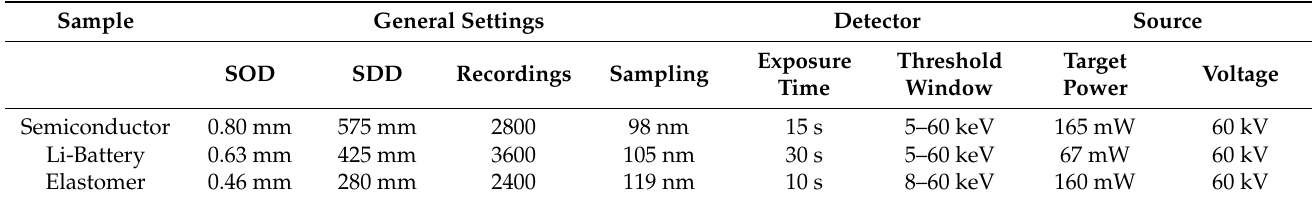
Table 1. Overview of acquisition parameters for the shown computed tomography measurements with source object distance (SOD), source-detector distance (SDD), number of exposures, effective sampling size, single image exposure time, detector threshold window (upper and lower threshold), power on the X-ray target and acceleration voltage.